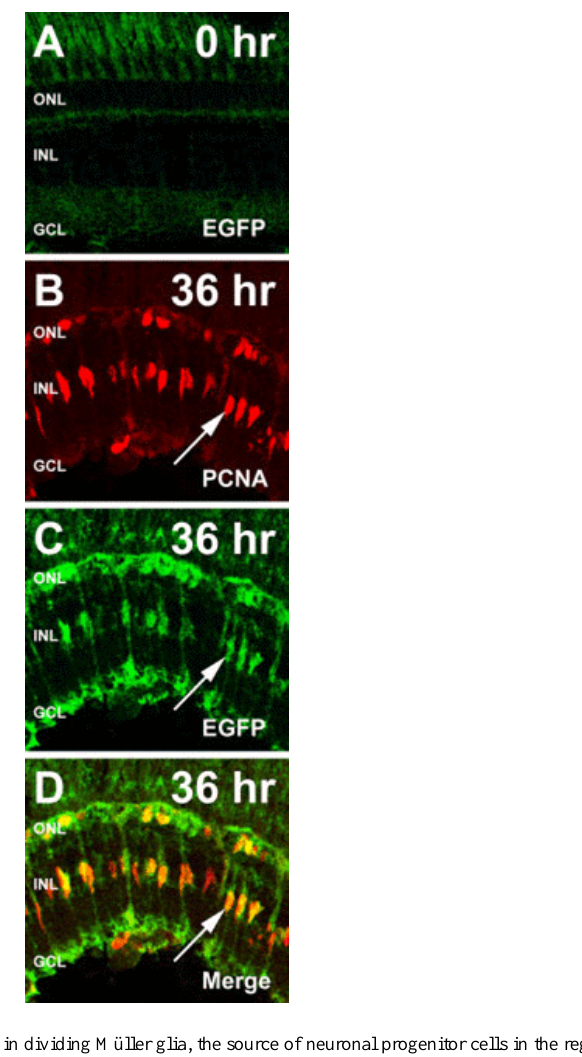
FIGURE 8. The ef1-a:EGFP transgene is expressed in dividing Müller glia, the source of neuronal progenitor cells in the regenerating zebrafish retina. Dark-adapted adult albino Tg (ef1-a:EGFP) nt were subjected to light treatment for either 0 h (panel A) or 36 h (panels B–D). Retinas were subsequently harvested and processed for immunolocalization of EGFP and PCNA. (A) At 0 h of light treatment, no EGFP expression from the ef1-a:EGFP transgene was observed in the retina. (B–D) Following 36 h of light treatment, PCNA-positive INL layer cells are observed (panel B), which colabel with the EGFP expressed from the ef1-a:EGFP transgene (panels C and D). The EGFP-expressing cells were determined to be Müller glia based on their morphology, which contain processes that extend from the ganglion cell layer to the outer limiting membrane (panel C), and that the Müller glia are the only PCNA-labeled cells in the INL at this time in regeneration[29]. INL, inner nuclear layer; ONL, outer nuclear layer; GCL, ganglion cell